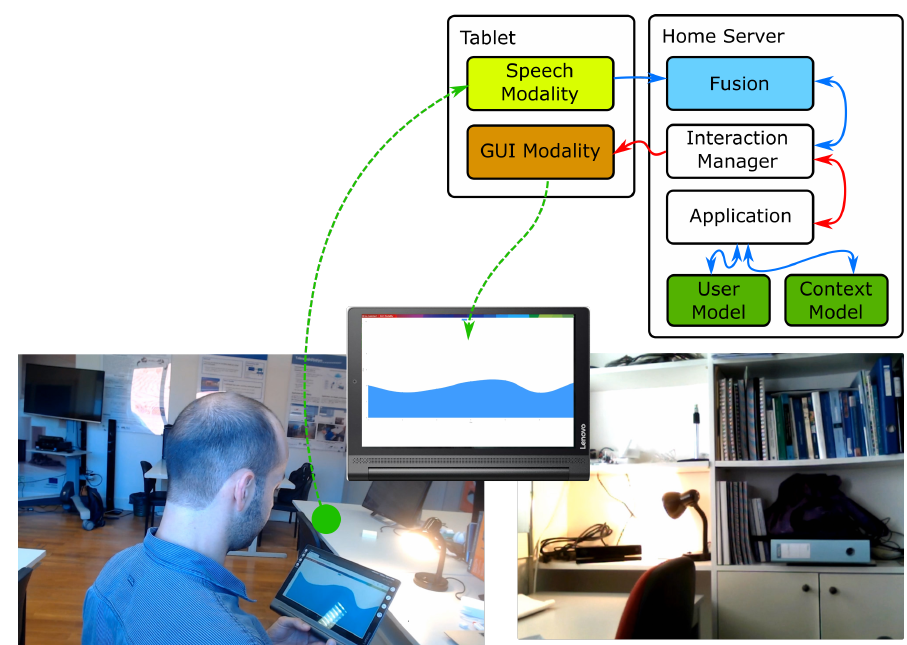
Figure 15. Images illustrating the use of the framework and assistant, in the smart home context, while using speech and GUI to obtain information regarding the consumption of water, in the